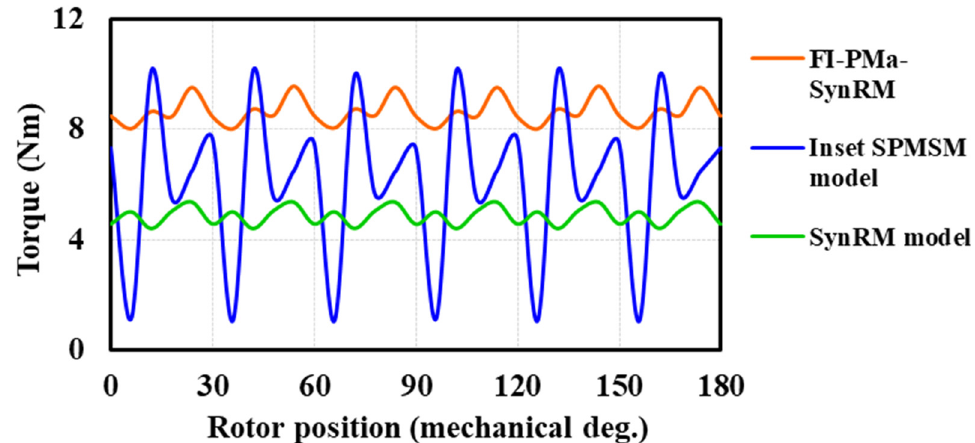
Figure 9. Torque vs. rotor positions.